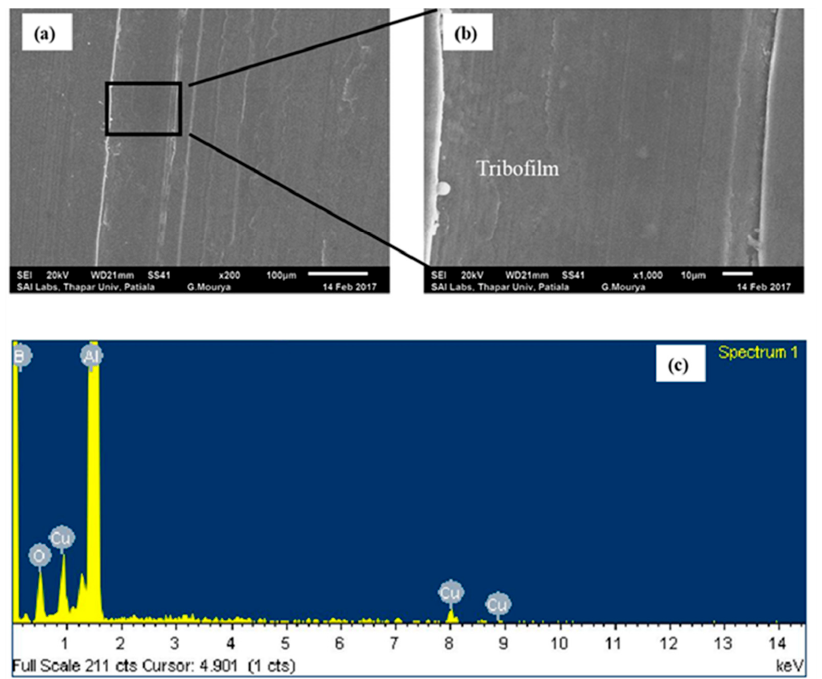
Figure 6. ( a ) SEM image of worn surface of the aluminium alloy disc lubricated with PAO + h-BN nanolubricant at 50 N load (200×) ( b ) magnified image (1000×) of Figure 6a; and ( c ) EDS spectrum of Figure 6a. Worn surface is smooth with tribofilm formation. Boron (B) peak in the EDS spectrum indicates the presence of h-BN nanoparticles on the worn surface. Nanomaterials 2021 , 11 , 1438 Addition of ND particles to PAO + CuO nanolubricant (i.e., PAO + CuO + ND) de- creases wear volume of Al alloy disc when compared to that under lubrication by PAO + CuO at all loads (Figure 2). At the lowest applied load of 10 N, a reduction of 28% in wear volume is observed due to the addition of ND particles to the PAO + CuO nanolubricant, and at the highest load of 50 N, there is a reduction of 20%. The worn surface of the disc tested with PAO + CuO + ND nanolubricant at the load of 50 N is shown in Figure 7a. Higher magnification image shows that the worn surface is smooth and is covered with CuO tribofilm (Figure 7b). Carbon (C) peak in the EDS spectrum indicates the presence of ND particles on the worn surface (Figure 7c). The addition of ND particles to PAO + h-BN nanolubricant (i.e., PAO + h-BN + ND) decreases wear volume of Al alloy disc when compared to that under lubrication by PAO + h-BN at all loads (Figure 3). At the lowest applied load of 10 N, a reduction of 63% in wear volume is observed due to the addition of ND particles to the PAO + h-BN nanolubricant and at the highest applied load of 50 N, a reduction of 38%. The worn surface of the disc tested with PAO + h-BN + ND nanolubricant is shown in Figure 8a. The higher magnification image shows that the worn surface is smooth and is covered with h-BN tribofilm (Figure 8b). Boron (B) peak in the EDS spectrum indicates the presence of h-BN, and carbon (C) peak indi- cates the presence of ND particles on the worn surface (Figure 8c).